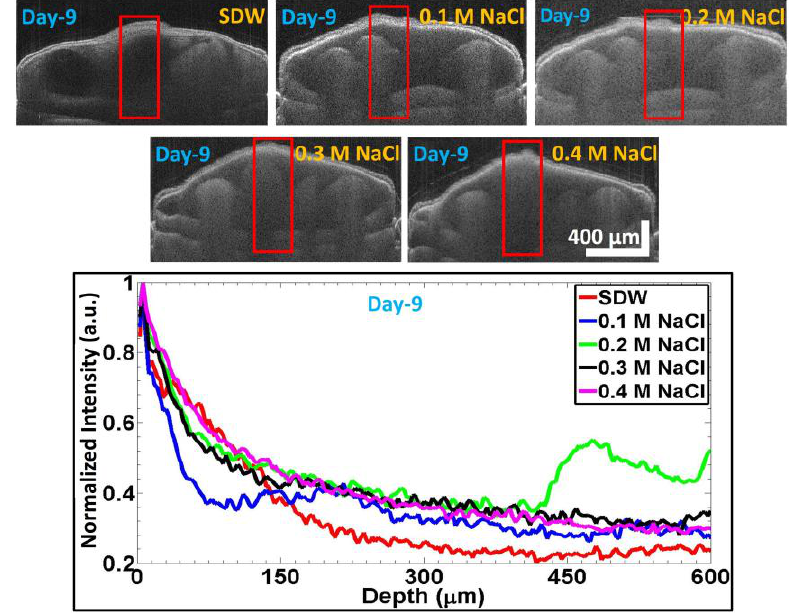
Figure 6. SS-OCT images on Day 9 after priming the Capsicum annuum seeds with different solutions. Bottom figure is the respective averaged and normalized depth profile analysis plot (as discussed in Section 2.4) for SDW, 0.1 M NaCl, 0.2 M NaCl, 0.3 M NaCl, and 0.4 M NaCl, which are correspondingly shown with colors of red, blue, green, black, and magenta plots.